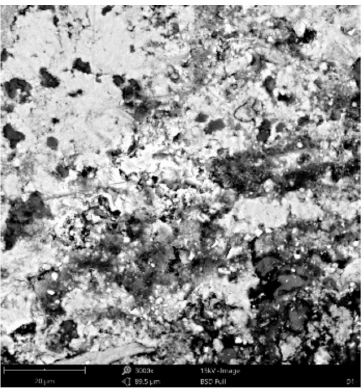
Figure 23. Phenom XL Desktop SEM